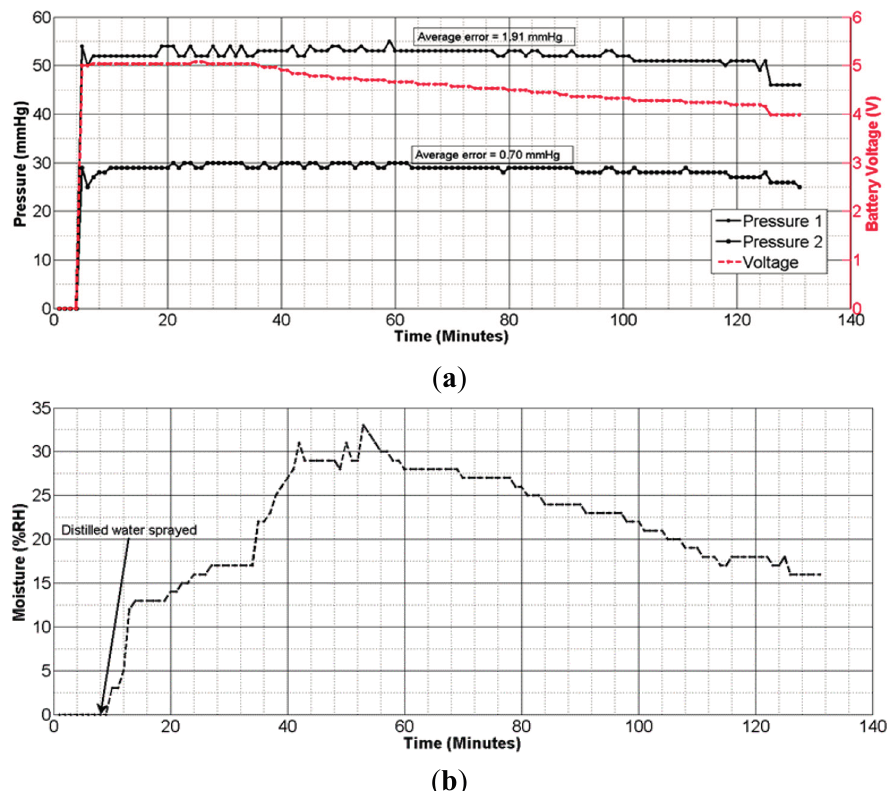
Figure 9. ( a ) Graphical plot of pressure measurements on a mannequin leg over time; ( b ) graphical plot of moisture measurements on a mannequin leg over time.